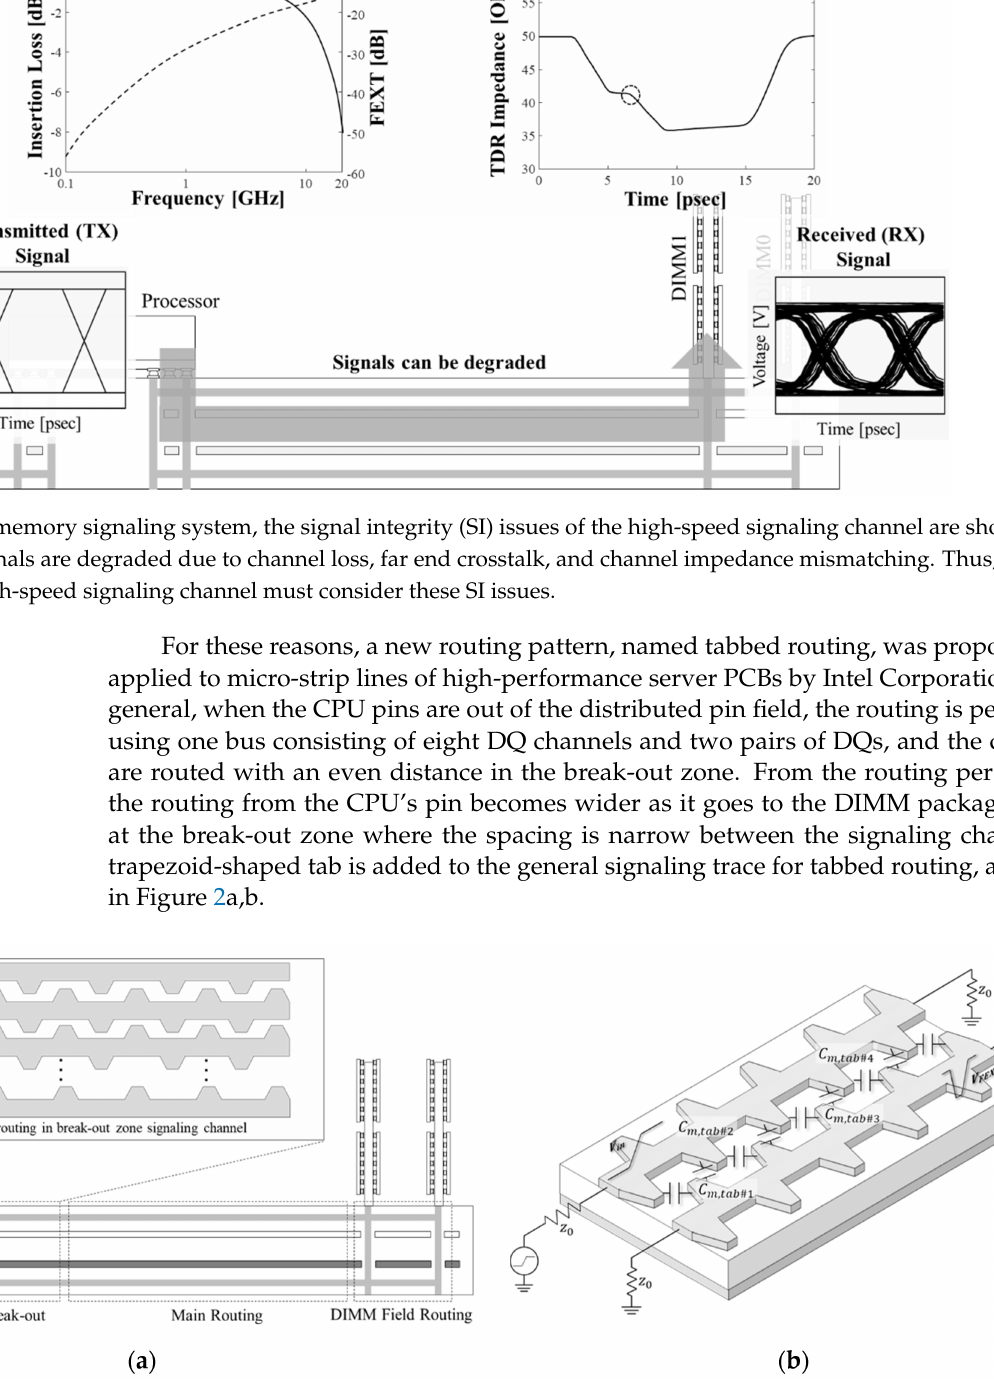
Figure 2. ( a ) Conceptual image of high-speed signaling channel in a high-performance server board from CPU to DIMM socket. The channel continues from the processor to pin field routing, break-out zone routing, and main routing. In the break-out zone routing, tabbed routing is applied to reduce the far-end cross-talk (FEXT) and match the overall TDR impedance. ( b ) Conceptual image high-speed signaling channel with tabbed routing and induced far-end crosstalk (FEXT) due to the aggressor channel. Due to tabbed routing, the additional mutual capacitance is applied. By changing the ratio of mutual- and self-capacitance and mutual- and self-inductance, the FEXT voltage differs depending on the change of tab